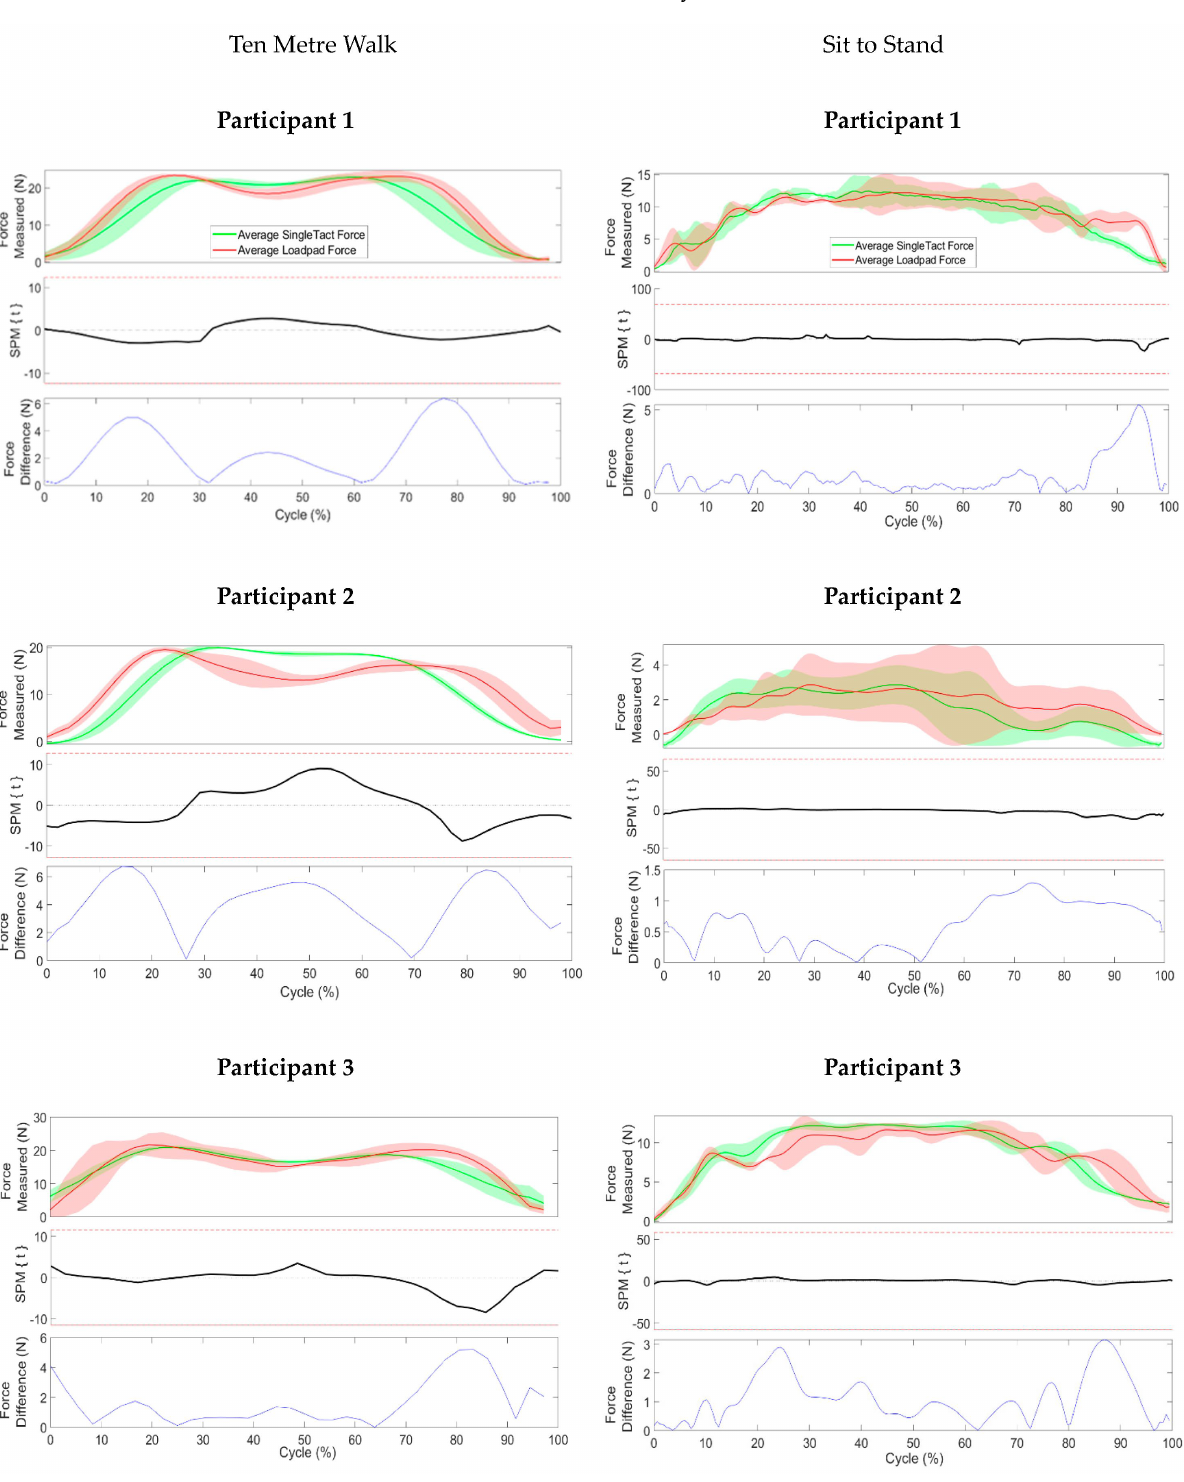
Figure 8. Force measurements from SingleTact and Loadpad at the distal end of the residual limb during walking (left column) and sit to stand (right column). The top graph for each participant represents the force measurements from the SingleTact (green) and Loadpad (red), the middle graph